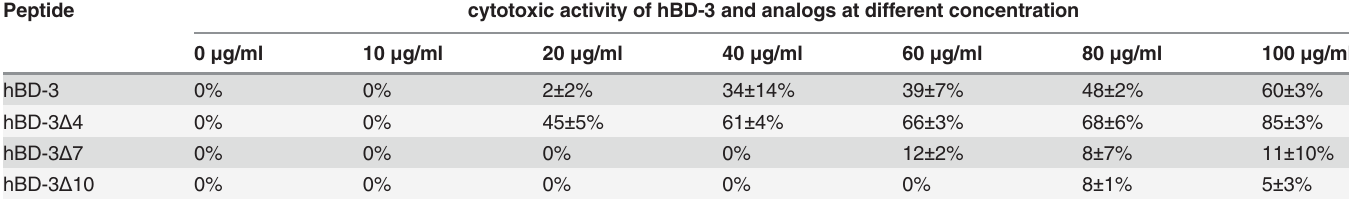
Table 4. Cytotoxic activity of hBD-3 and analogs at different concentration. Peptide cytotoxic activity of hBD-3 and analogs at different